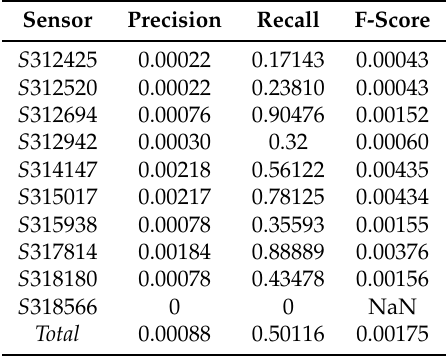
Table 7. Quality of fit for the Phase 1-Train data using standard normal deviates.